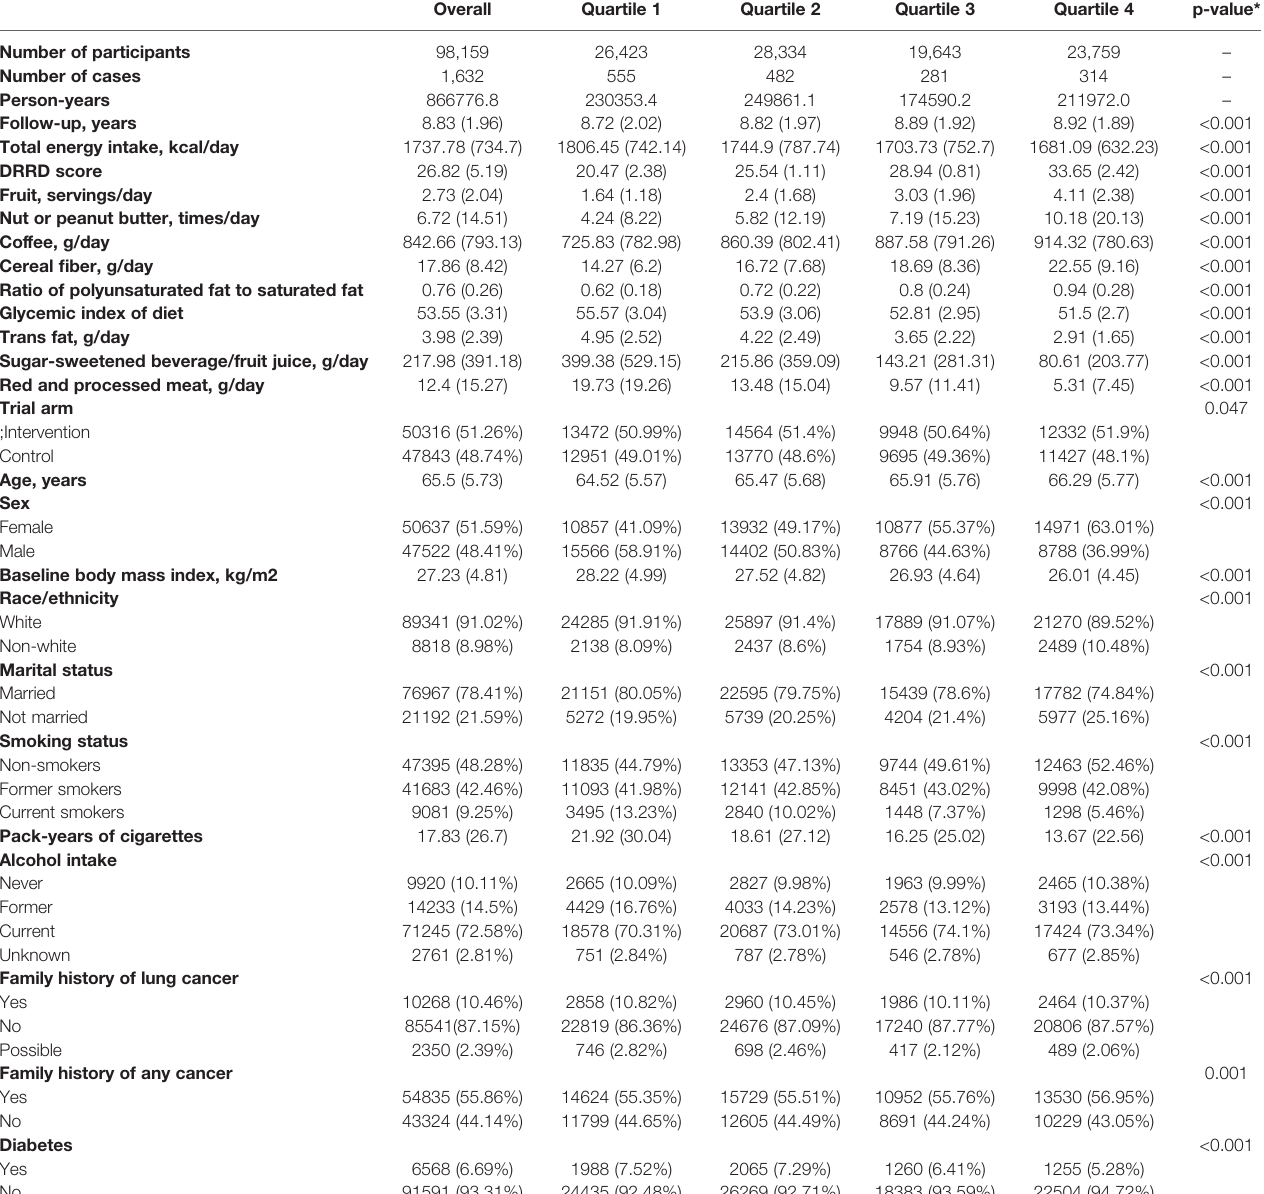
TABLE 1 | Baseline characteristics of 98,159 participants from Prostate, Lung, Colorectal, and Ovarian Cancer Screening Trial by DRRD